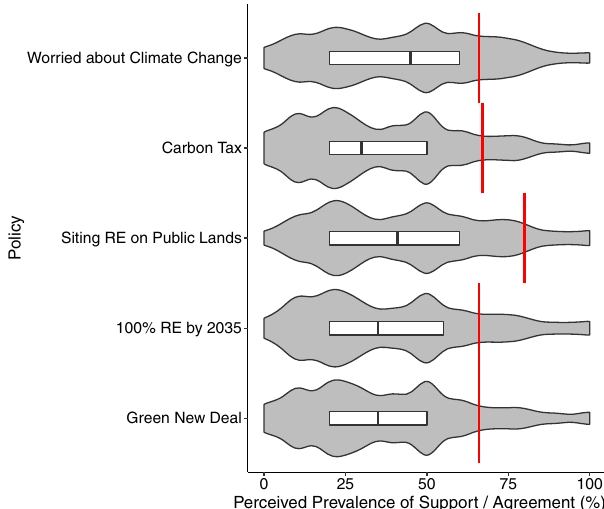
Fig. 1 | Perceived climate change worry and support for climate policies com- paredtoactuallevels. Boxesinsidetheviolinplotrepresentthemiddle50%ofthe sample, with a line at the median, while the minima and maxima illustrated represent the full range of responses (from 0 – 100%). The red line represents the trueprevalence,asindicatedbycontemporaneousnationalpolling 12,43 .RErefersto renewable energy. N =6119 survey participants.